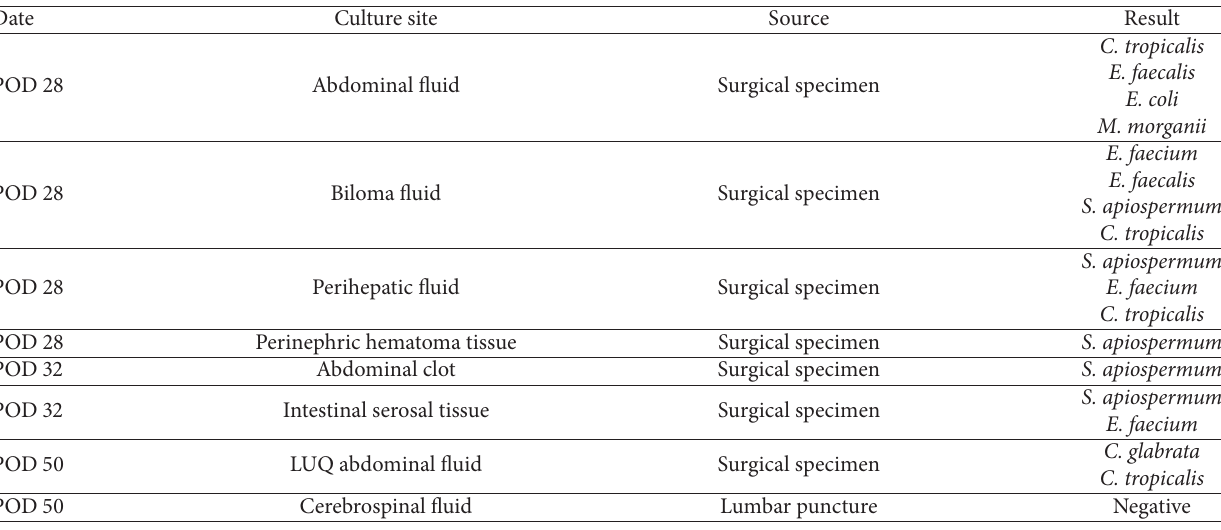
Table 1: Culture results.